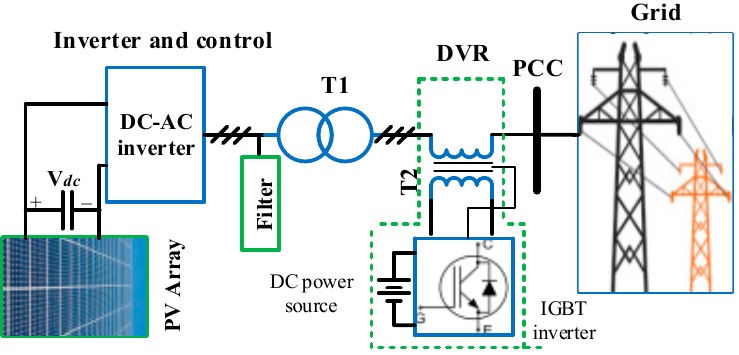
Figure 7. Grid-connected PV systems (GCPS) with a dynamic voltage regulator.